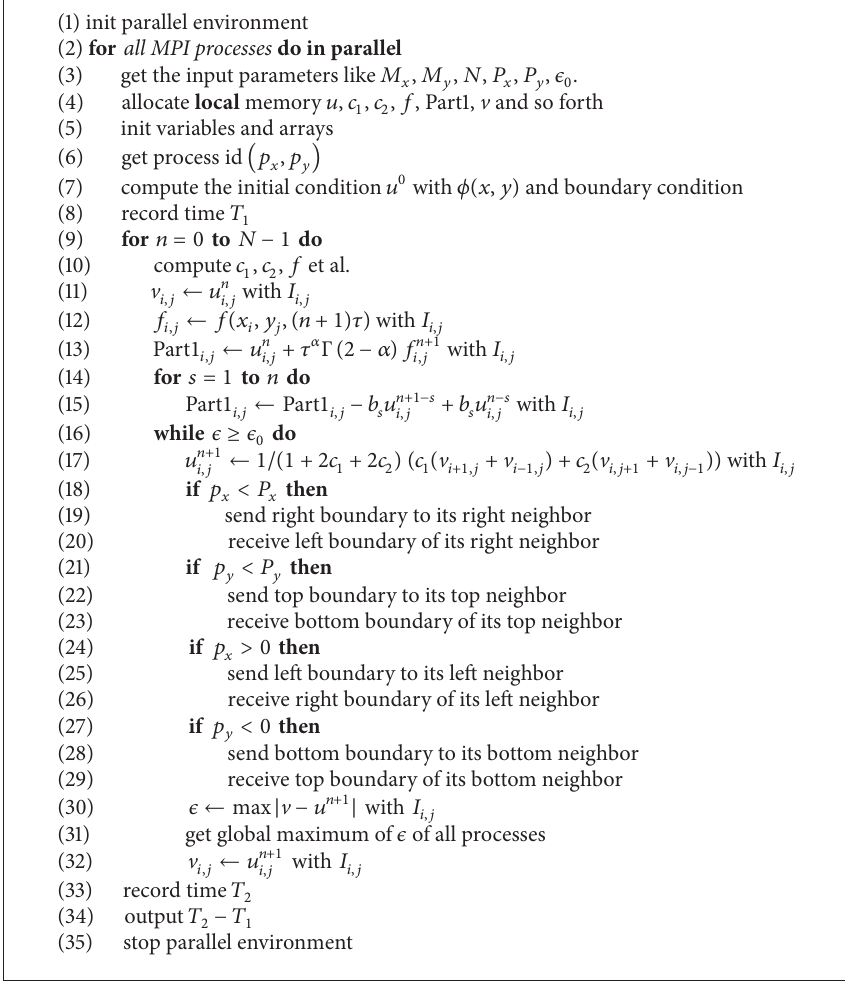
Algorithm 1: Parallel algorithm for 2D-TFDE.